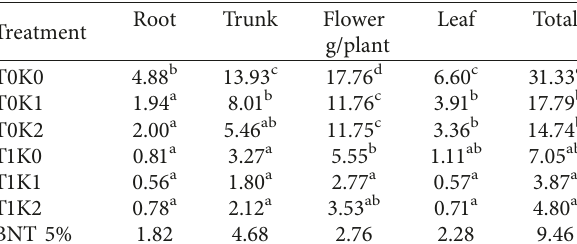
Table 2: Wet weight of